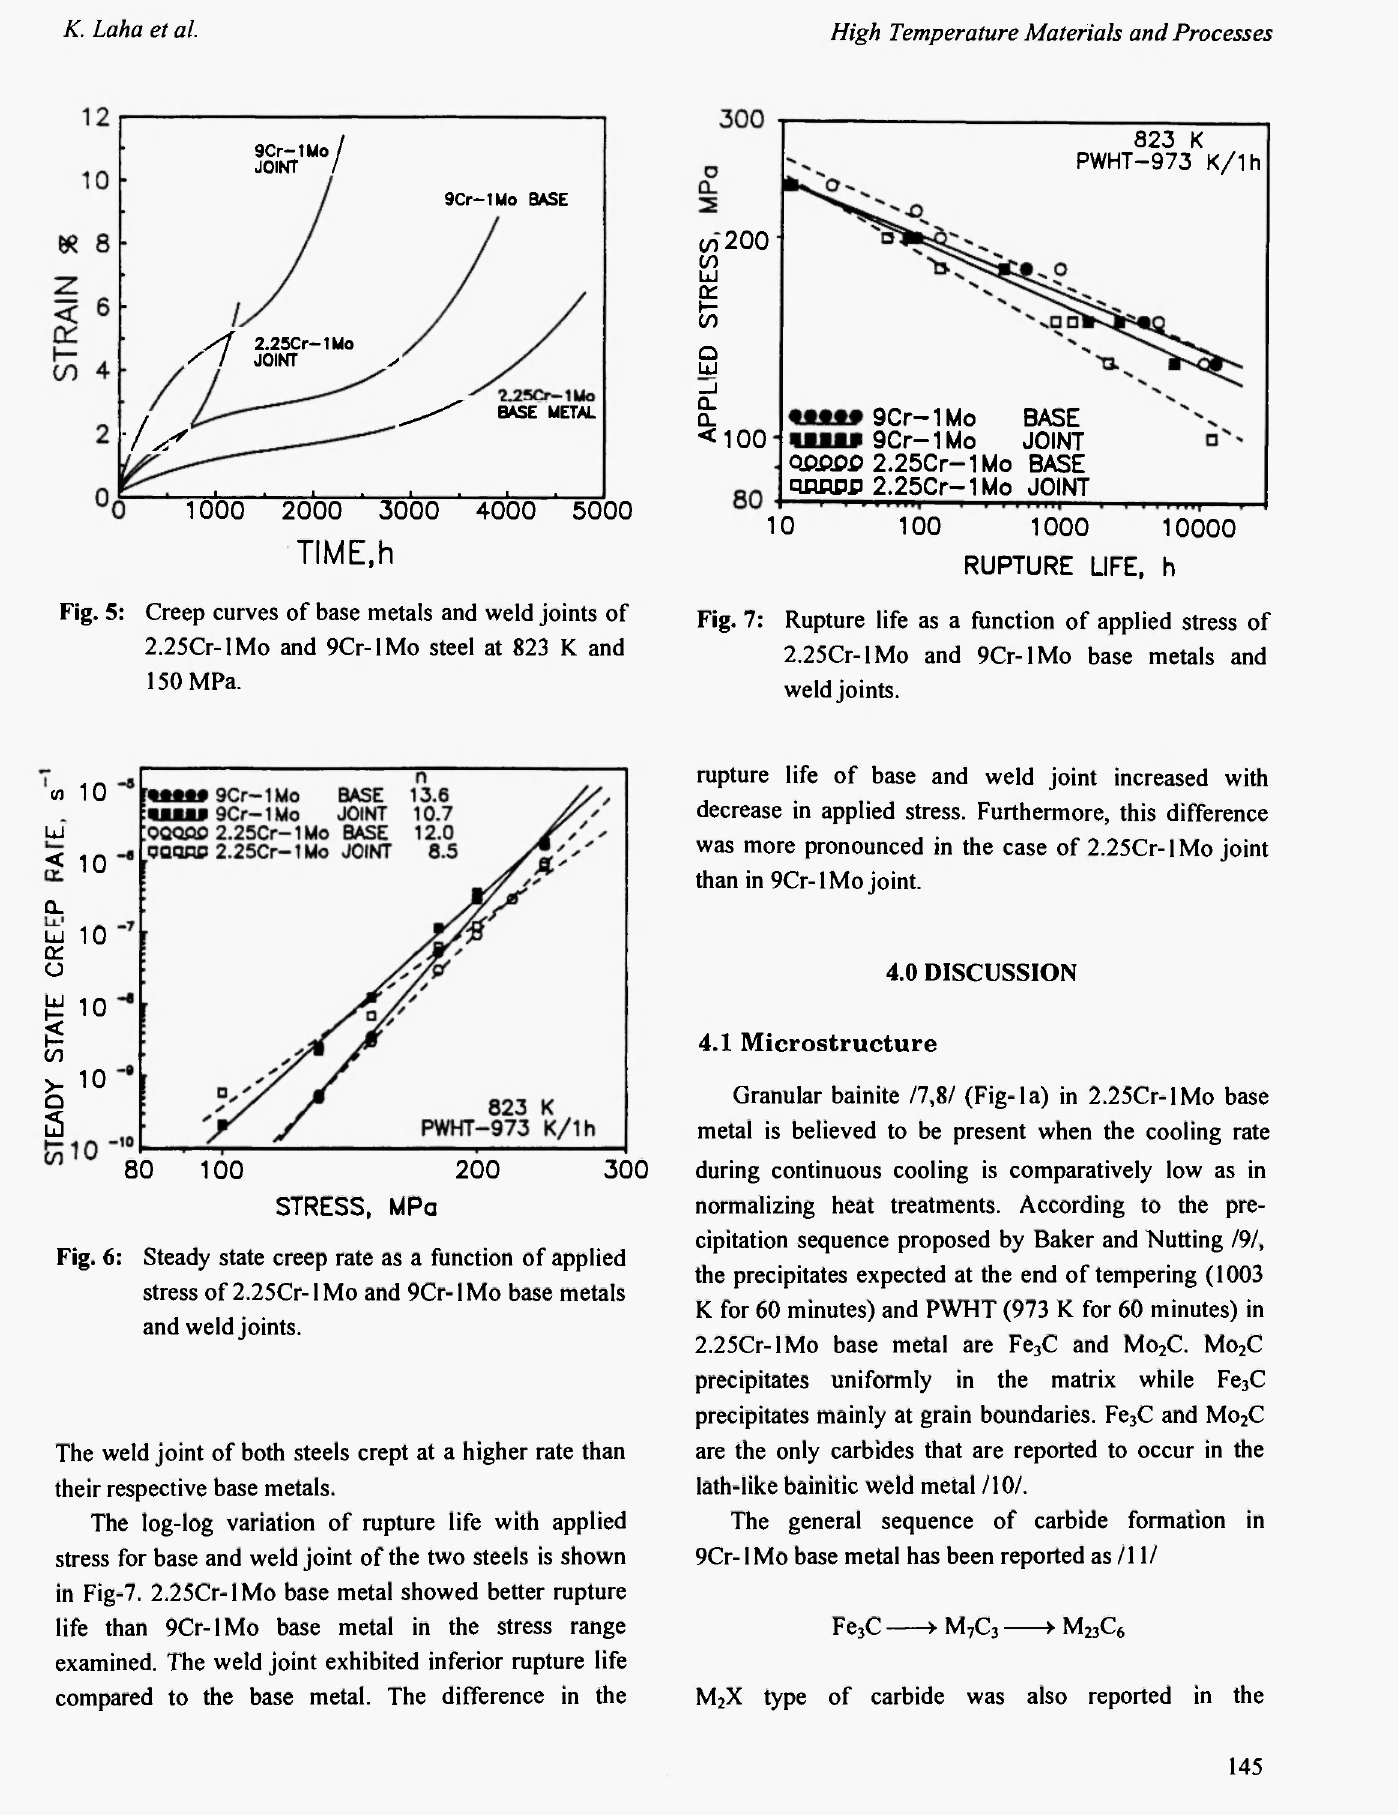
Fig. 5: Creep curves of base metals and weld joints of 2.25Cr-lMo and 9Cr-lMo steel at 823 Κ and 150 MPa.